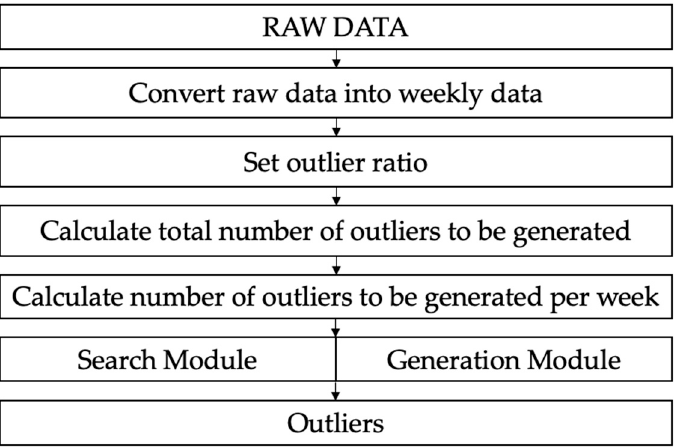
Figure 4. The overall algorithm for two methods: search module and generation module.